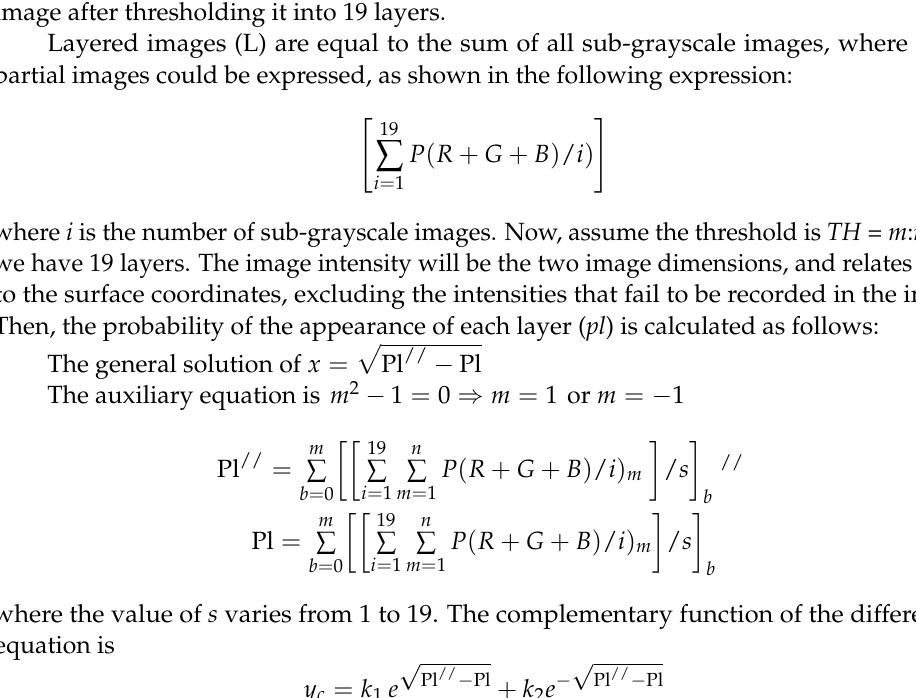
Figure 1. Schematic for the prototyped color-thresholding auto-detection method. The prototyped method is based on multilevel color-thresholding that segments a greyscale image into several distinct regions by using intensity. This system uses two thresh- olds to segment the image into certain regions of brightness, which correspond to at least one background and several other objects. We used a layer divisor to convert the resulting image after thresholding it into 19